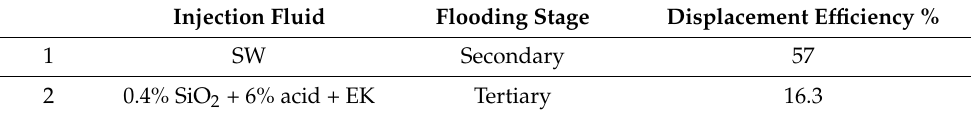
Table 15. Summary of CF8.